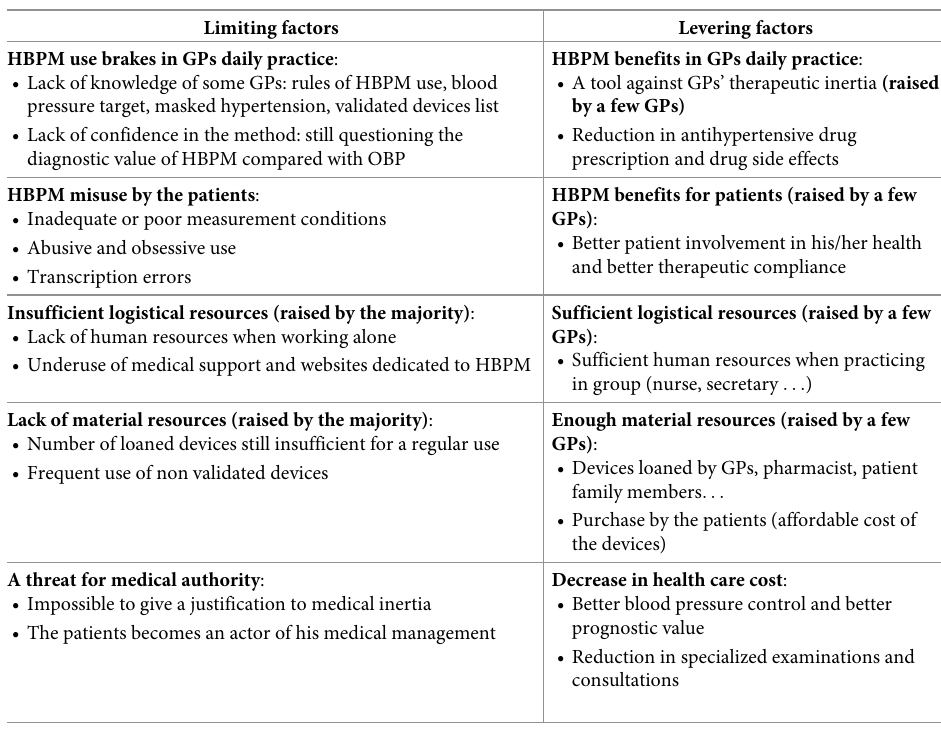
Table 3. Perceived limits and benefits of